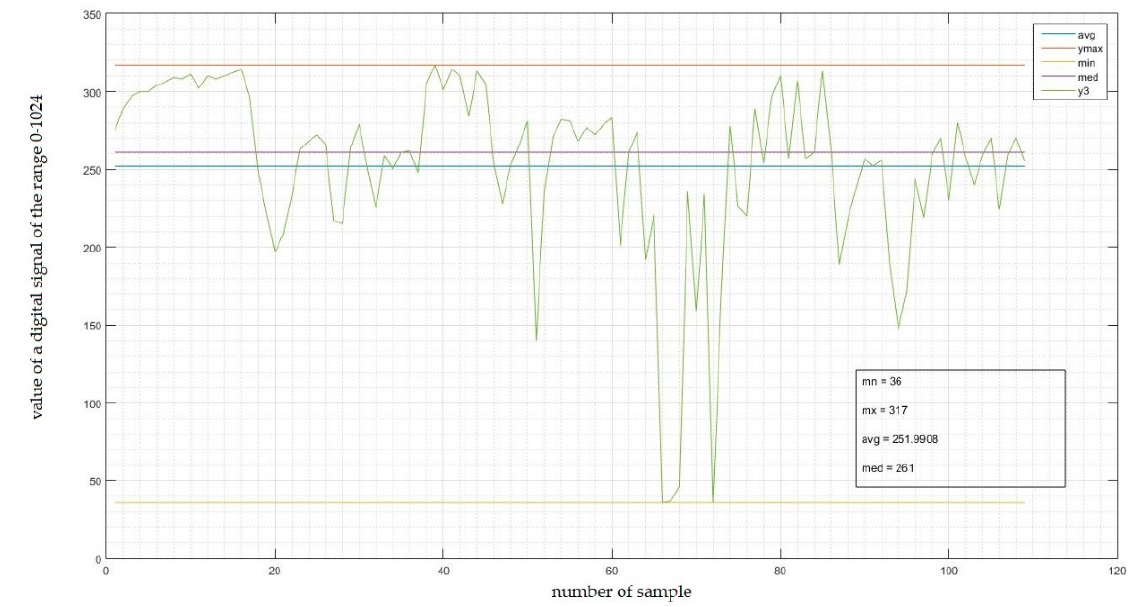
Figure A8. Data from the sensor on a straight ring finger.